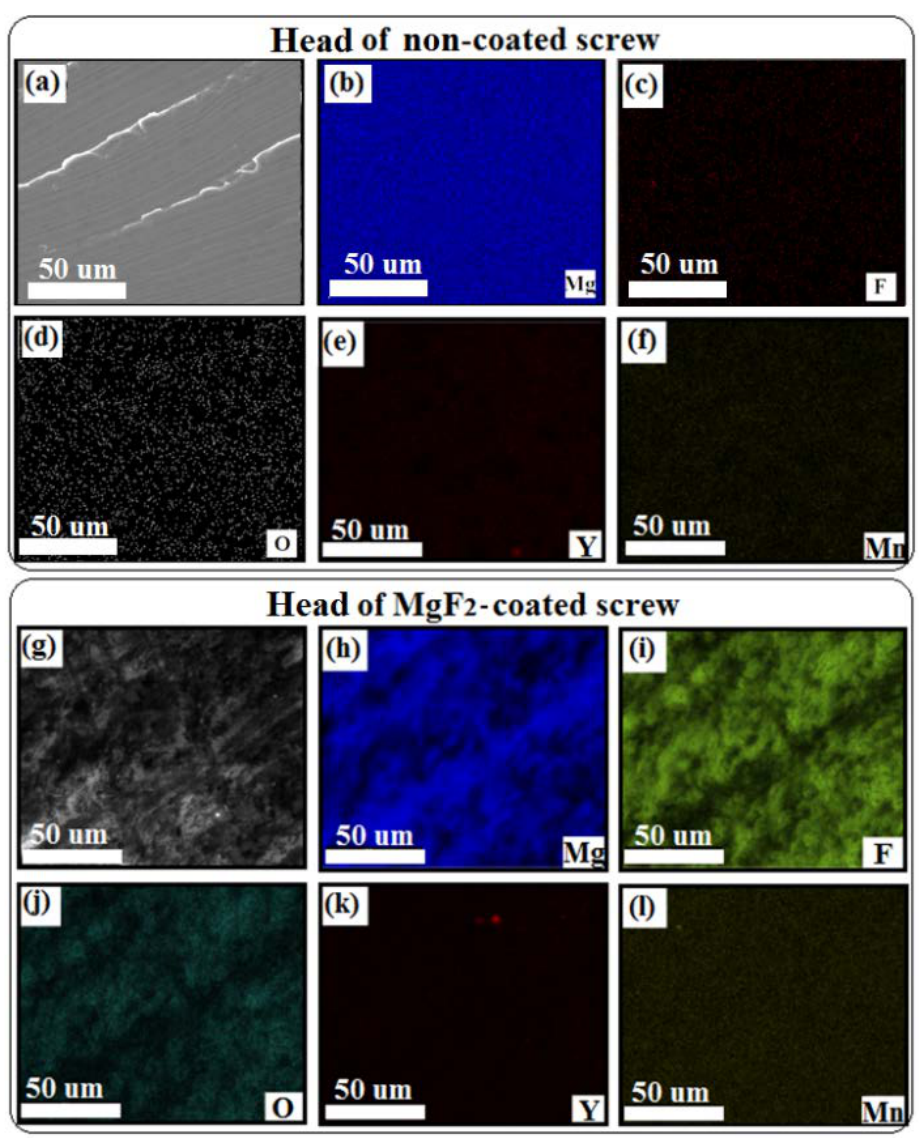
Figure 3. EDS mapping of MgF 2 -coated screws; elements distribution of the tip ( a – f ) and of the thread ( g – l ).